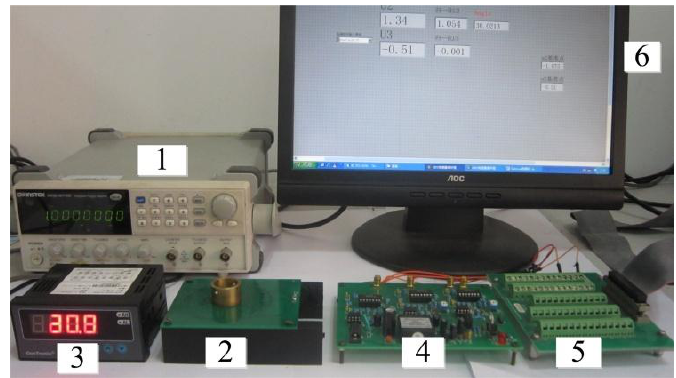
Figure 9. Configuration of the experimental